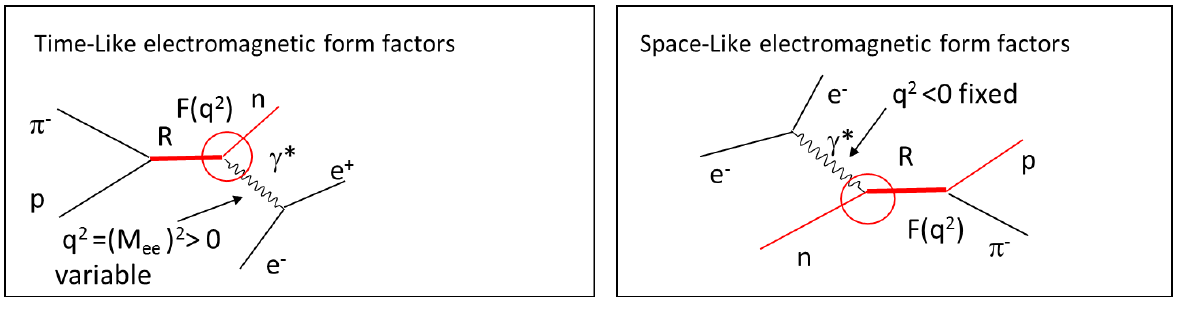
Figure 1. Left: Sketch of the Dalitz decay process of a resonance produced in the s-channel in a π − p reaction. The four-momentum transfer q 2 is positive and takes values between 4 m 2 and ( M B − M N ) 2 , where M ee is the e + e − invariant mass, m e , M B and M N are e the electron, baryon resonance and nucleon masses, respectively. Right: Excitation of a nucleon by electron scattering. The four- momentum transfer q 2 is negative and fixed by the energy and angle of the scattered electron.